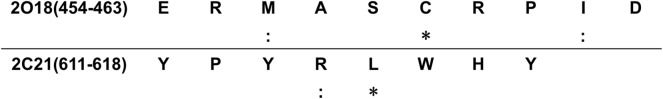
Conservation analysis of antibodies 2O18 and 2C21 epitopes.Five hundred and thirty-six HCV protein sequences from Table 5 were retrieved for alignment, and the conserved amino acid residues within 2O18 and 2C21 epitopes were marked. “:” indicates highly conserved residues, while “*” indicates absolutely conserved residues across 536 sequences.